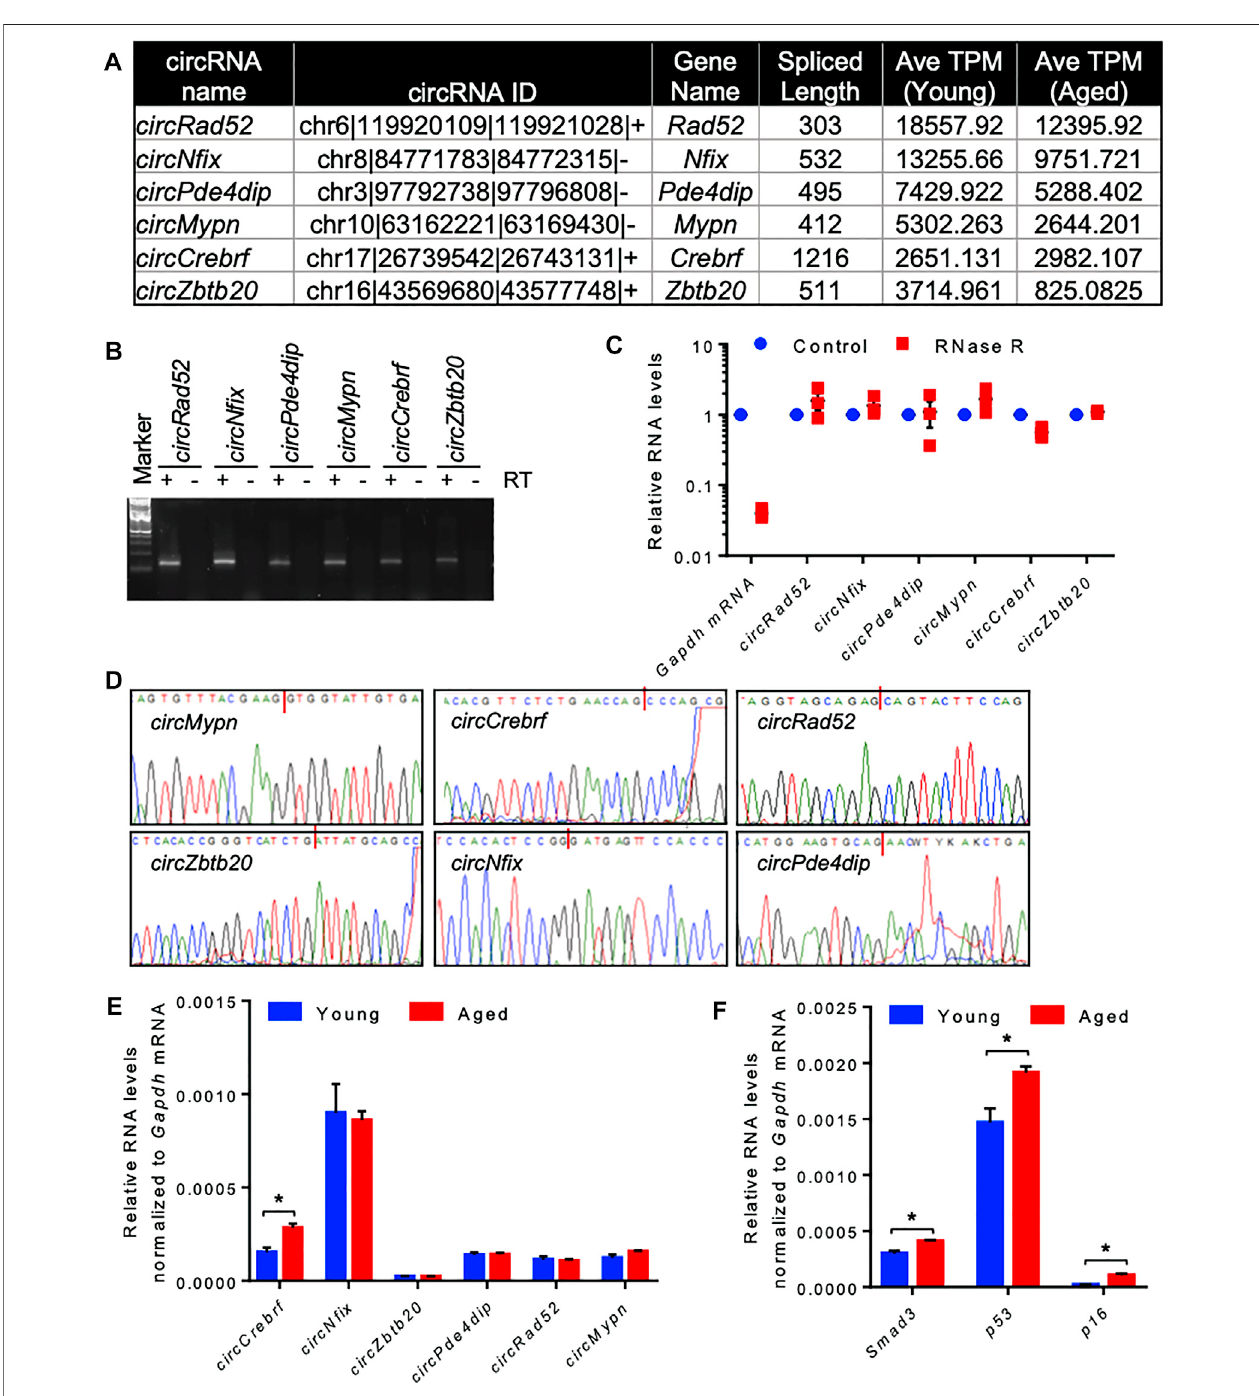
FIGURE 2| Differential expression and validation of circRNAs in aging skeletal muscle. (A) . A list of abundant circRNAs was selected for further validation. (B) . The RT-PCRproductsofcircRNAsfrommuscletissuewereresolvedona2%agarosegelstainedwithSYBRGold. (C) .RT-PCRanalysisofcircRNAsandlinearRNAsupon RNase R treatment. (D) . PCR products of circRNAs from muscle were puri fi ed and sequenced to con fi rm the backsplice sequences. (E,F) . RT-qPCR analysis of circRNAs (E) and mRNAs (F) in young and aged skeletal muscle normalized to Gapdh mRNA. Data in (C,E,F) are the means ± SEM from three independent experiments. *, p <